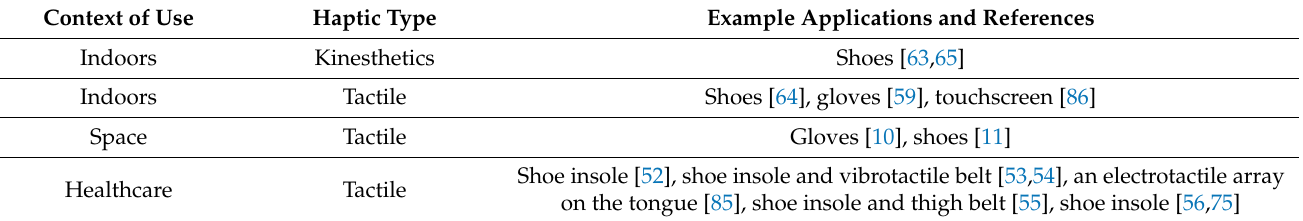
Table 3. Contexts of use for academic haptic